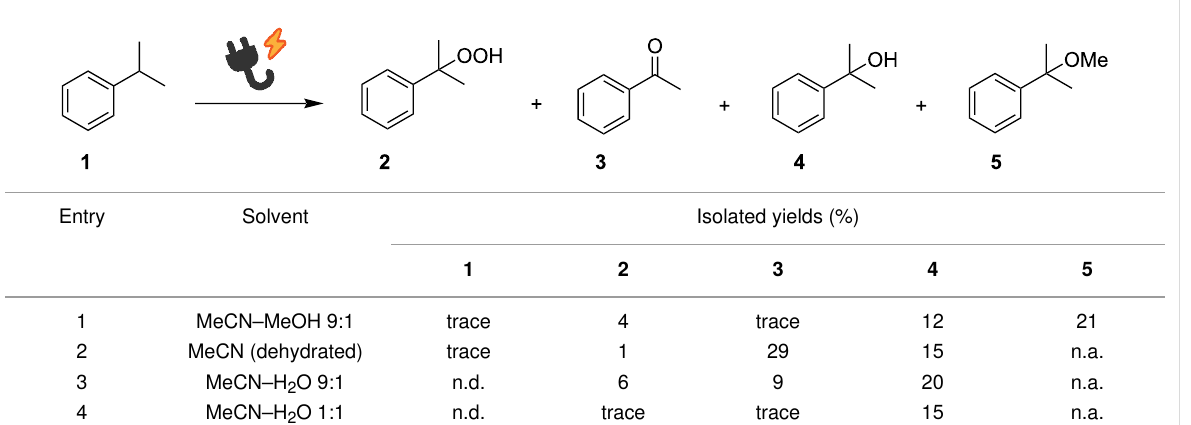
Table 2: Control electrolysis experiments of 1 a